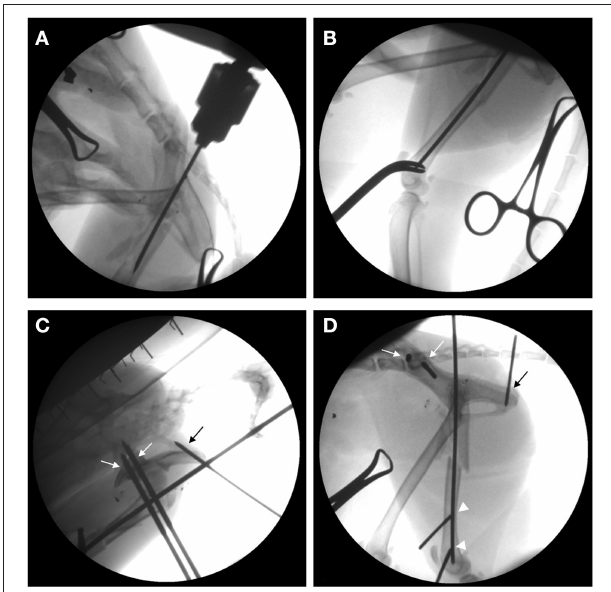
FIGURE 2 | Intraoperative fluoroscopic series showing closed reduction and implant insertion in a 2-year-old cat with a comminuted proximal femur fracture. (A,B) The intramedullary pin is inserted into the trochanteric region, normograde from proximal to distal (A) , and it stabilizes the proximal and the distal femoral diaphyseal fragments (B) . (C,D) For trans-articular external skeletal fixation of the hip, three of the five positive-profile end-threaded pins are inserted to the left pelvis, including two pins in the ileum (white arrows) and the third pin in the ischium (black arrow), while the other two pins are placed in the distal fragments of the fractured femur (white arrowheads).